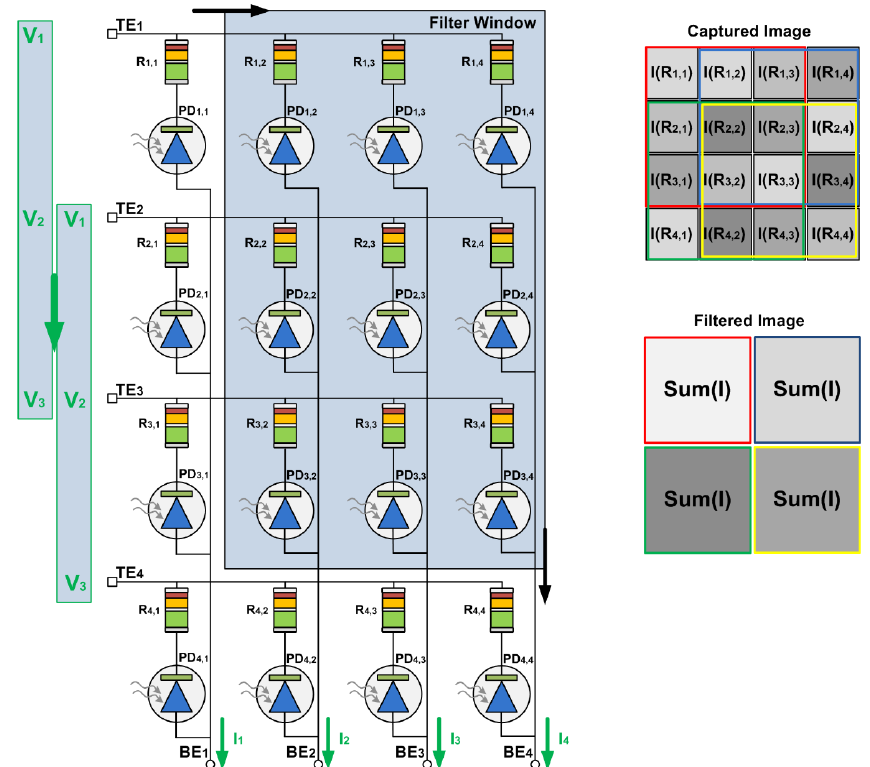
Figure 7. 1D1M vision sensor architecture, where the read mask together with the virtual corresponding filter window is depicted with boxes colored with a light blue color. The moving read mask with the corresponding virtual filter window is marked by light blue boxes. Each pixel of the filtered image is color marked with the same color as the corresponding convolutional region of the captured image.